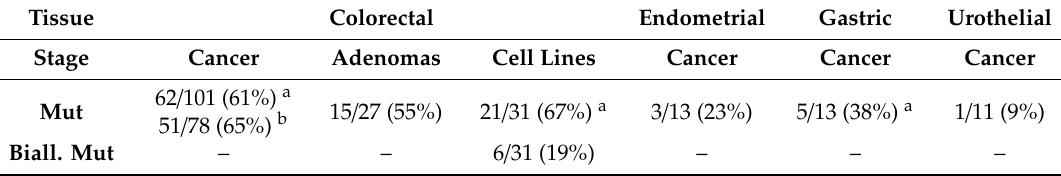
Table 2. Frameshift mutation frequencies in di ff erent tumor entities for the A9-repeat of UPF3A